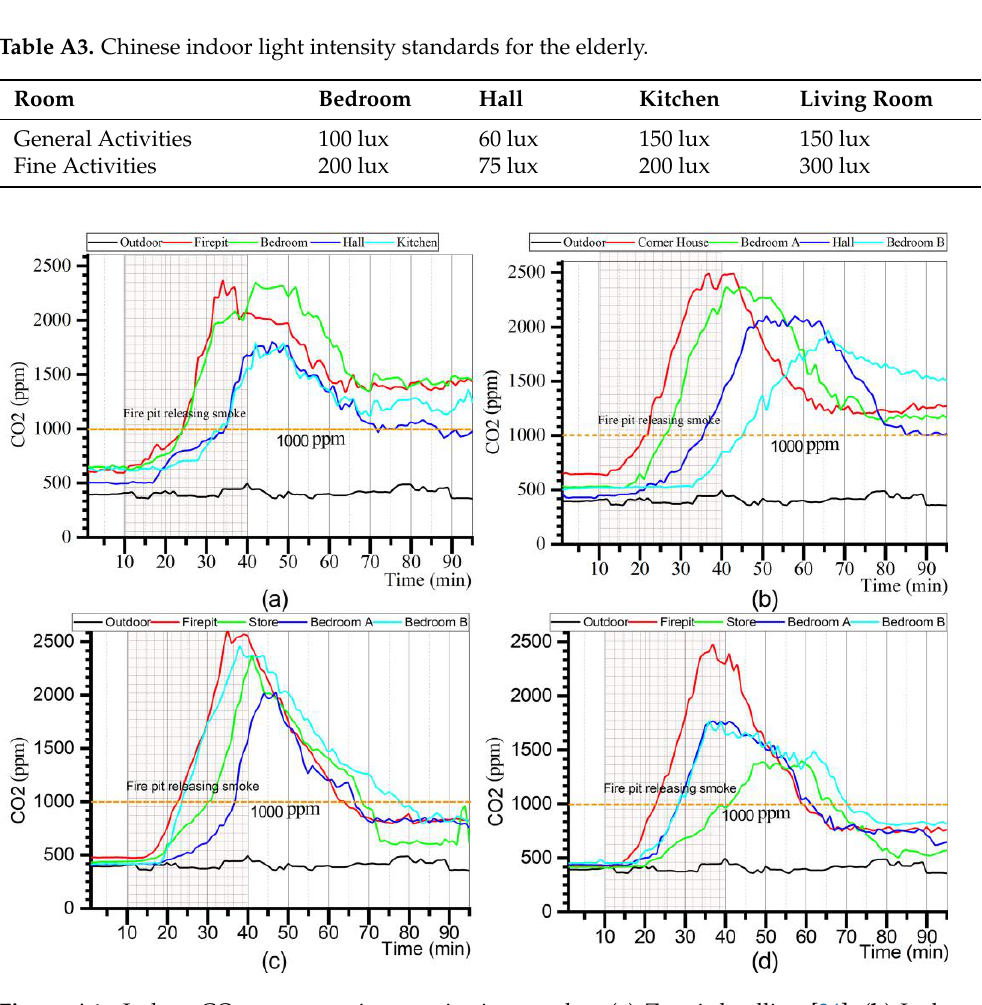
Figure A1. Indoor CO 2 concentration monitoring results. ( a ) Zuozi dwelling [34], ( b ) L-shape dwelling [34], ( c ) lower store and upper house dwelling, ( d ) front store and back house dwelling.